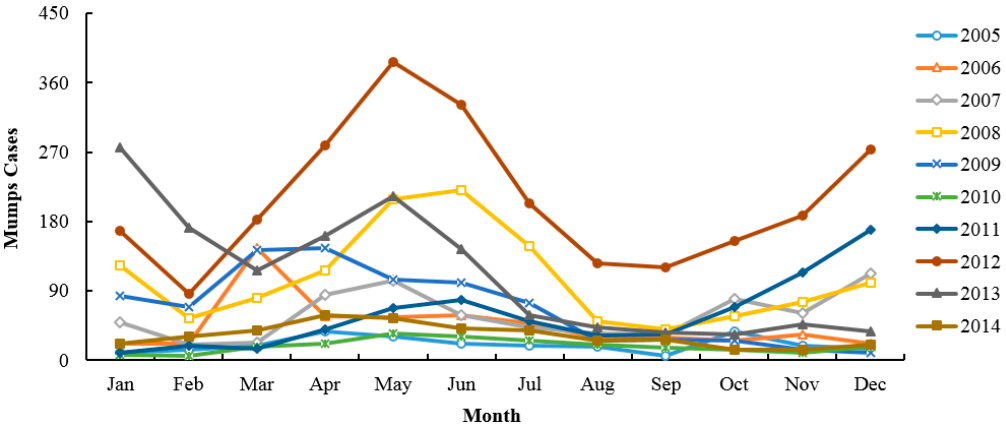
Figure 2. Monthly mumps cases from 2005 to 2014 in Zibo City.